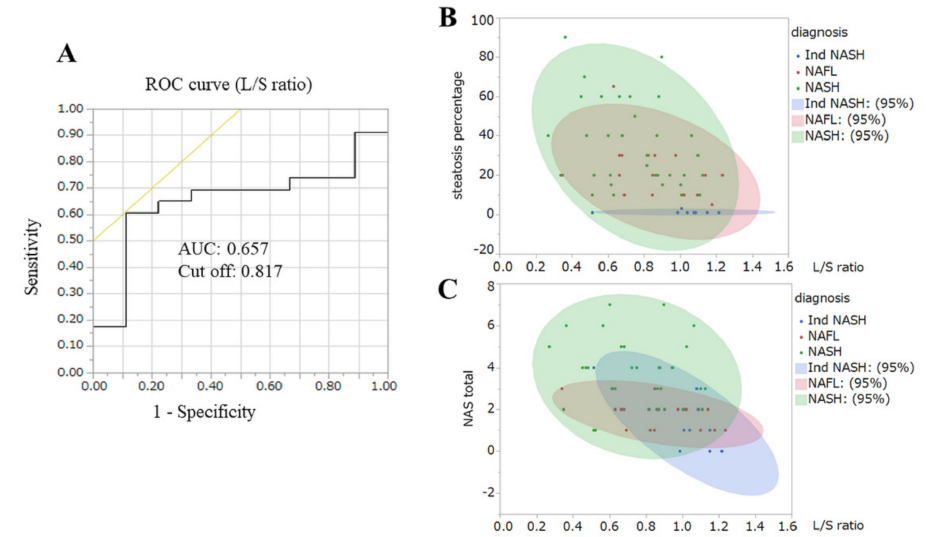
Figure 9. ( A ) The ROC curve revealed the cut-off and AUC of L/S ratio. ( B ) Scatter plots between steatosis and L/S ratio. Almost all blue plots (Ind-NASH) were in higher L/S ratio locations. ( C ) Almost all blue plots (Ind-NASH) were in low NAFLD activity score locations.